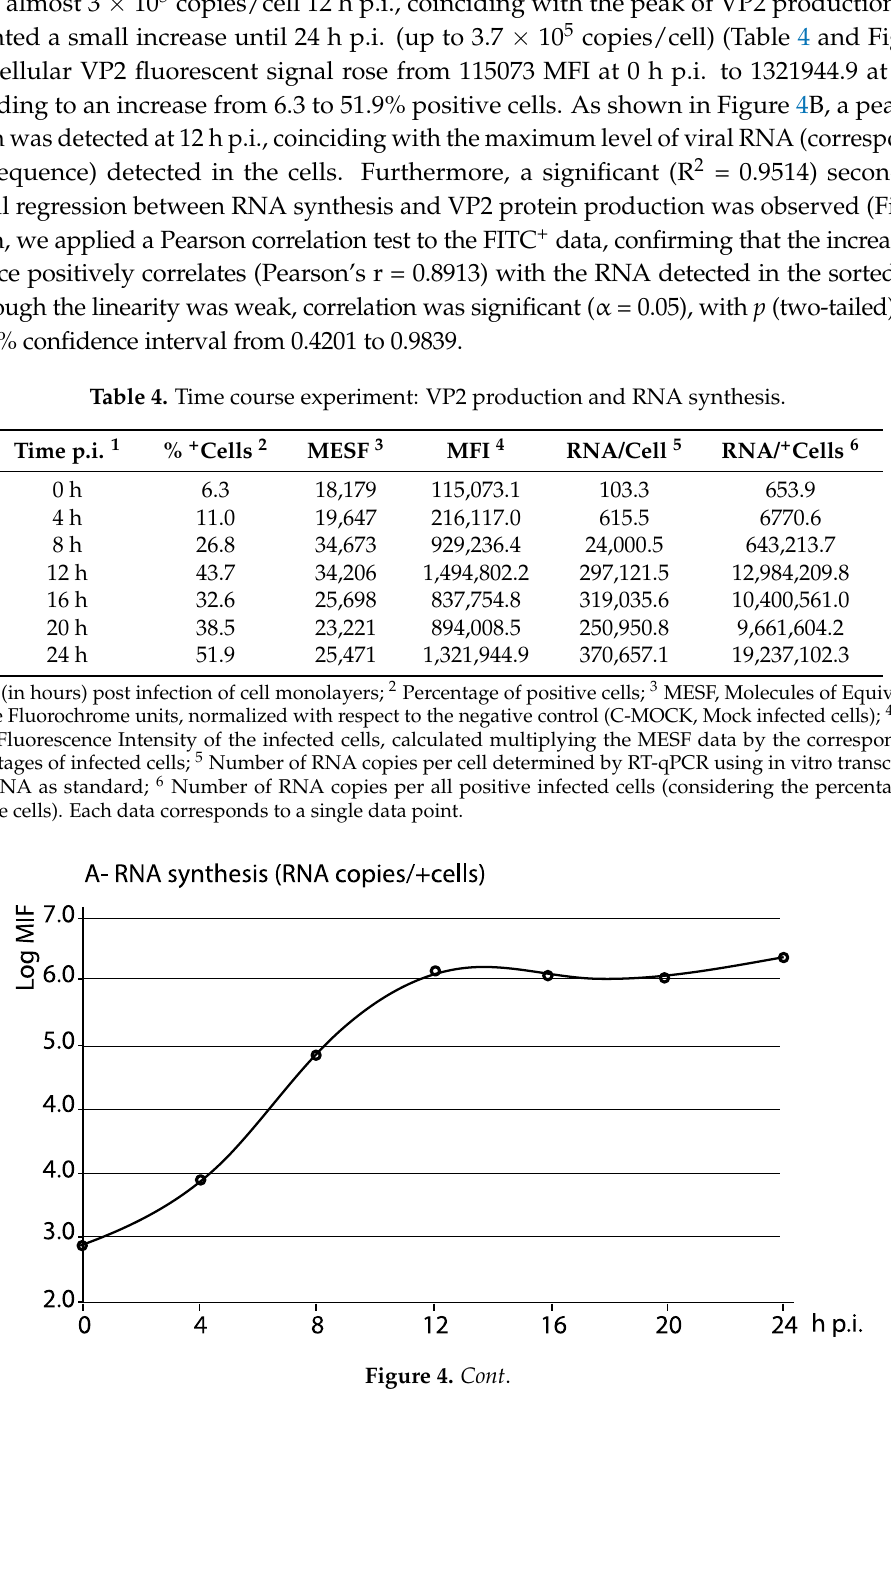
Figure 4. Quantification of VP2 protein production and RNA synthesis. The kinetics of RNA synthesis ( A ) and VP2 protein production ( B ) were studied in the first 24 h of viral replication in BF-2 cells. In addition, the correlation between both has been assessed ( C ). Each data corresponds to a single data point.